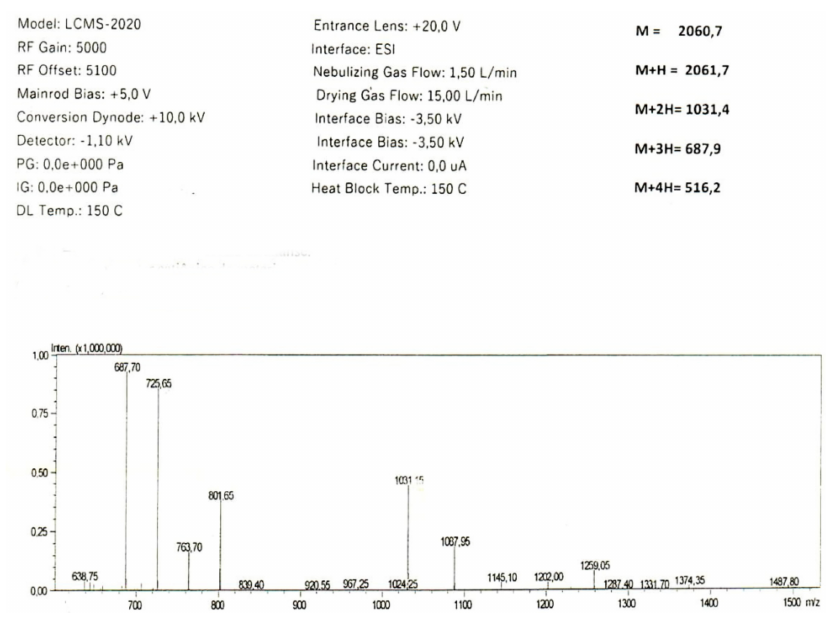
Figure A5. Mass spectroscopy analysis of peptide StigA25.